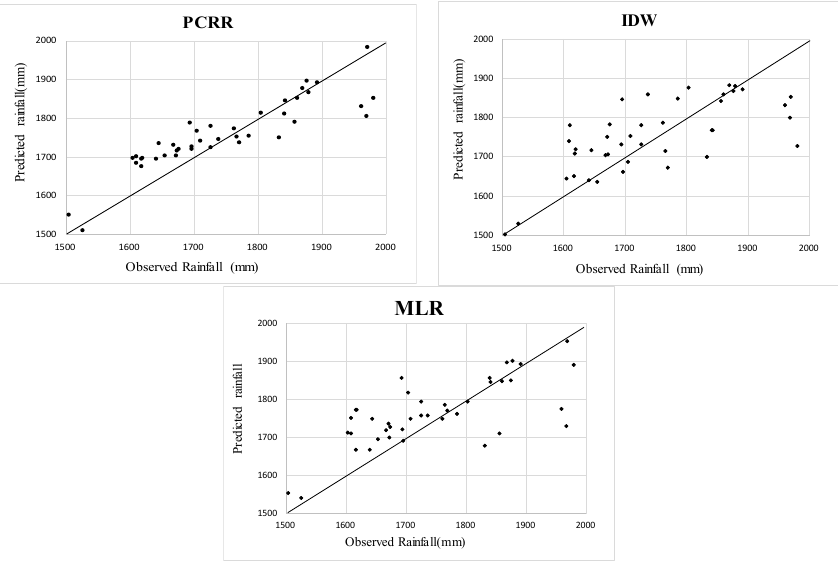
Figure 2. Scatterplots of observed versus predicted values for all interpolation methods of annual precipitation.